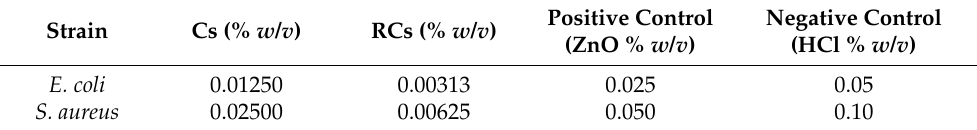
Table 4. Antibacterial activity of Cs and RCs.